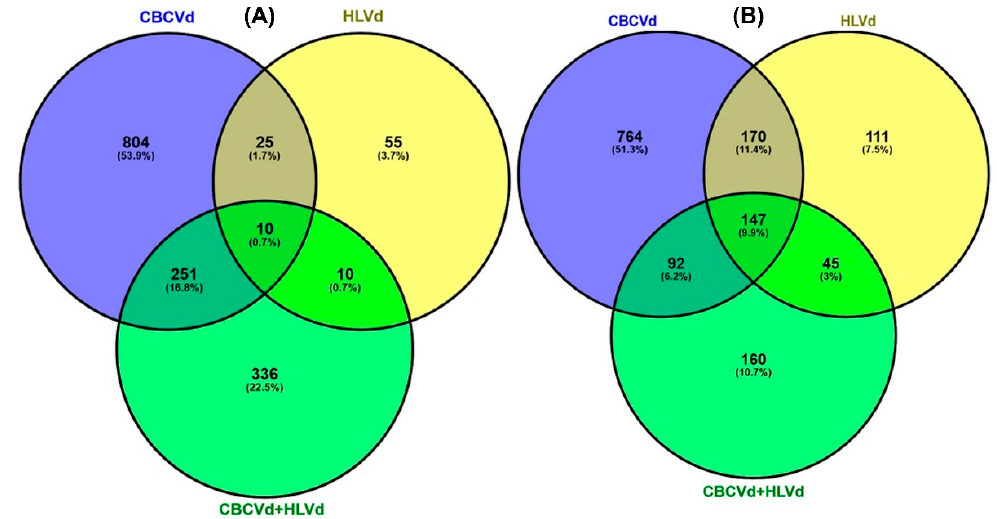
Figure 4. Venn diagrams of upregulated ( A ) and downregulated ( B ) genes identified in single CBCVd, HLVd infected, and HLVd-CBCVd coinfected hop plants.